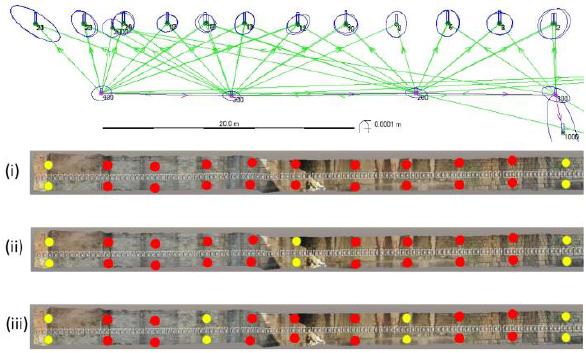
Fig. 2. The straight wall used to try out the accuracy of image orientation. Top: 3D points measured with a total station; bottom: the different ground control points (yellow) and check points (red) used in the different image-based